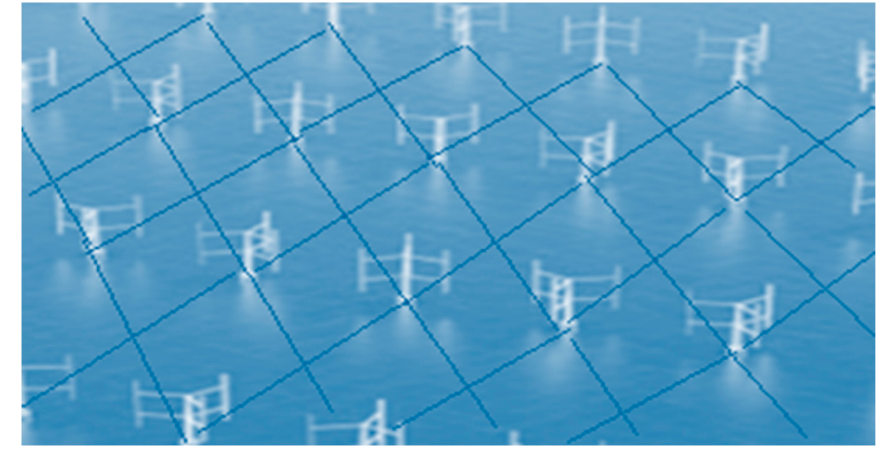
Figure 12. VAWT offshore wind farm. The average performance of two VAWTs in parallel against a varying array angle with a distance between them of 2 diameters is shown in Figure 13.